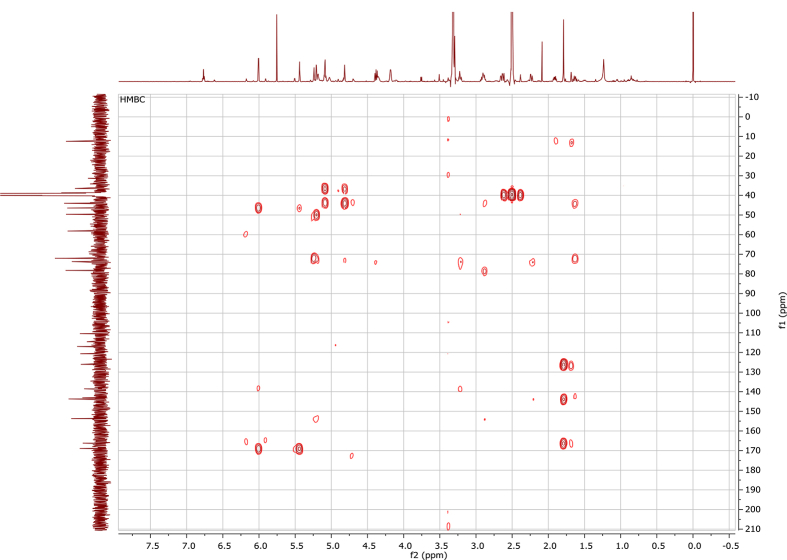
HMBC (DMSO-d6) spectrum of compound 13.